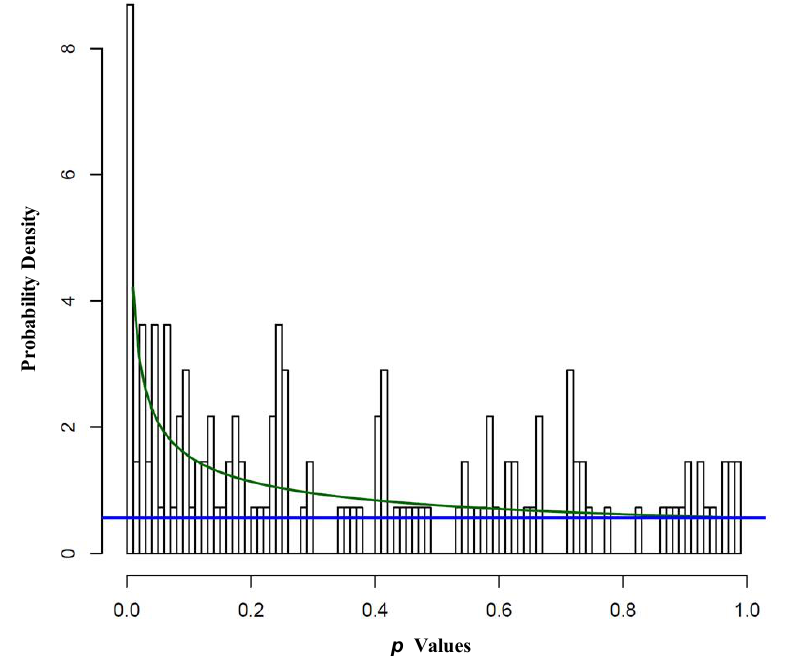
values of 138 drugs 50 and REST score. 50